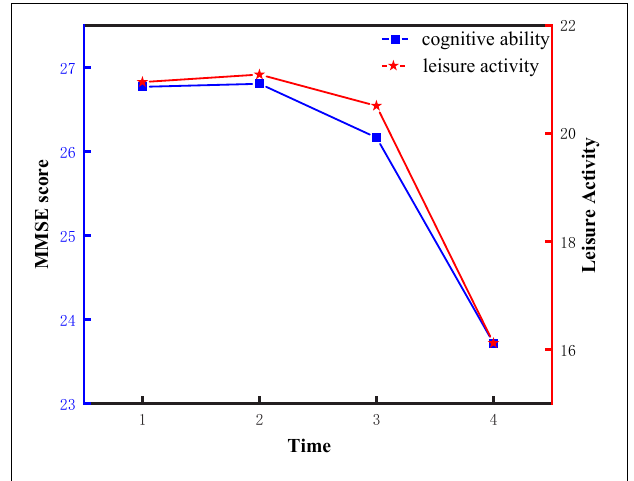
FIGURE 2 | Change trajectory of cognitive ability and leisure